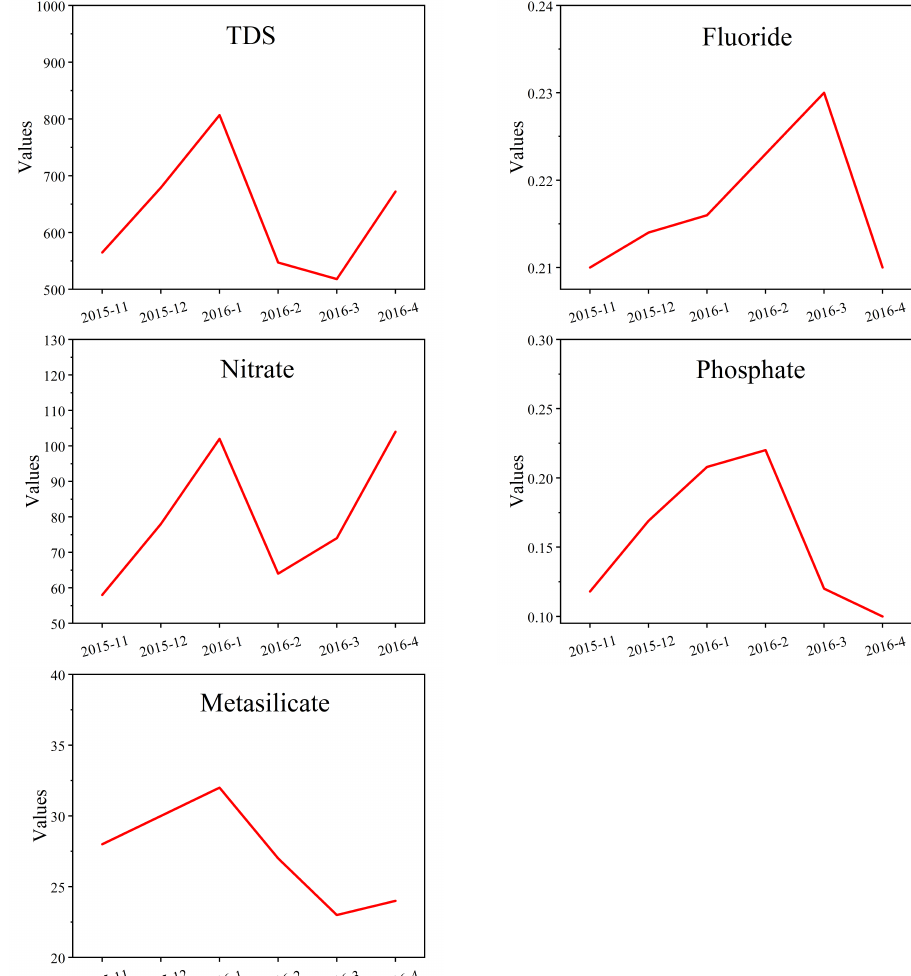
Figure 6. The predicted concentration values of five indicators during the next